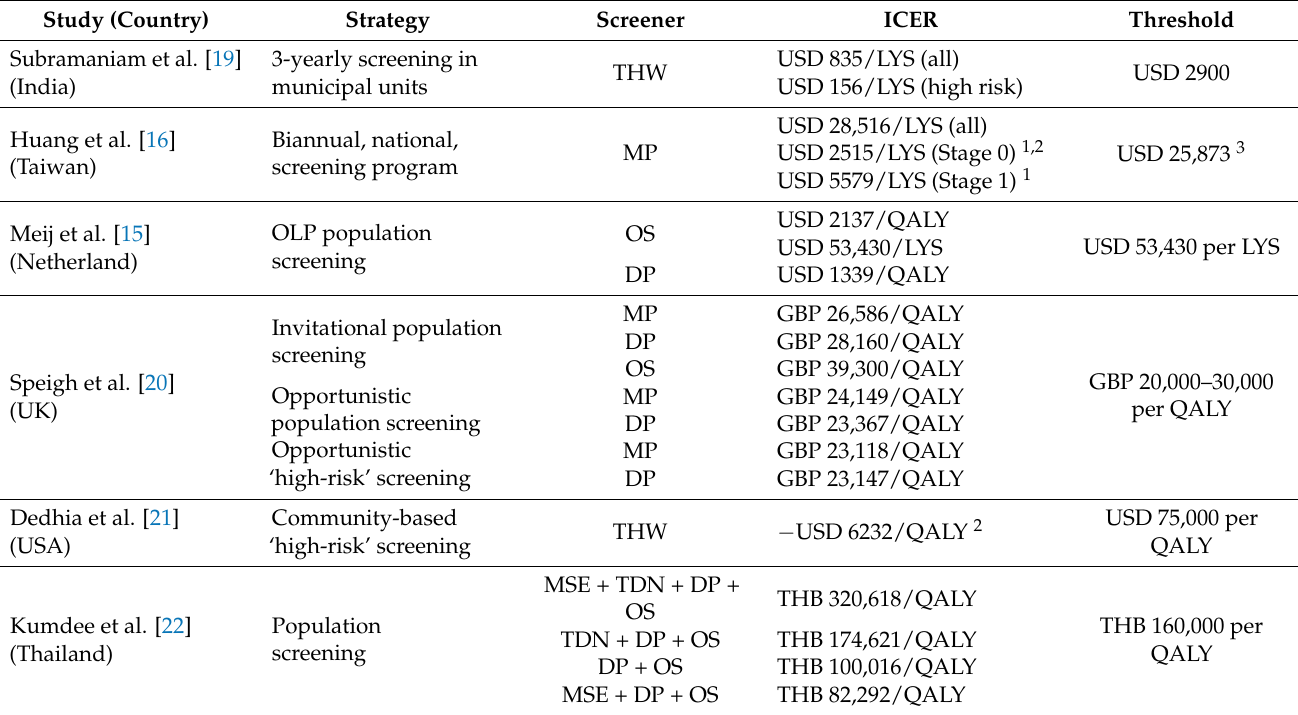
Table 3. Summary of ICER values by screening